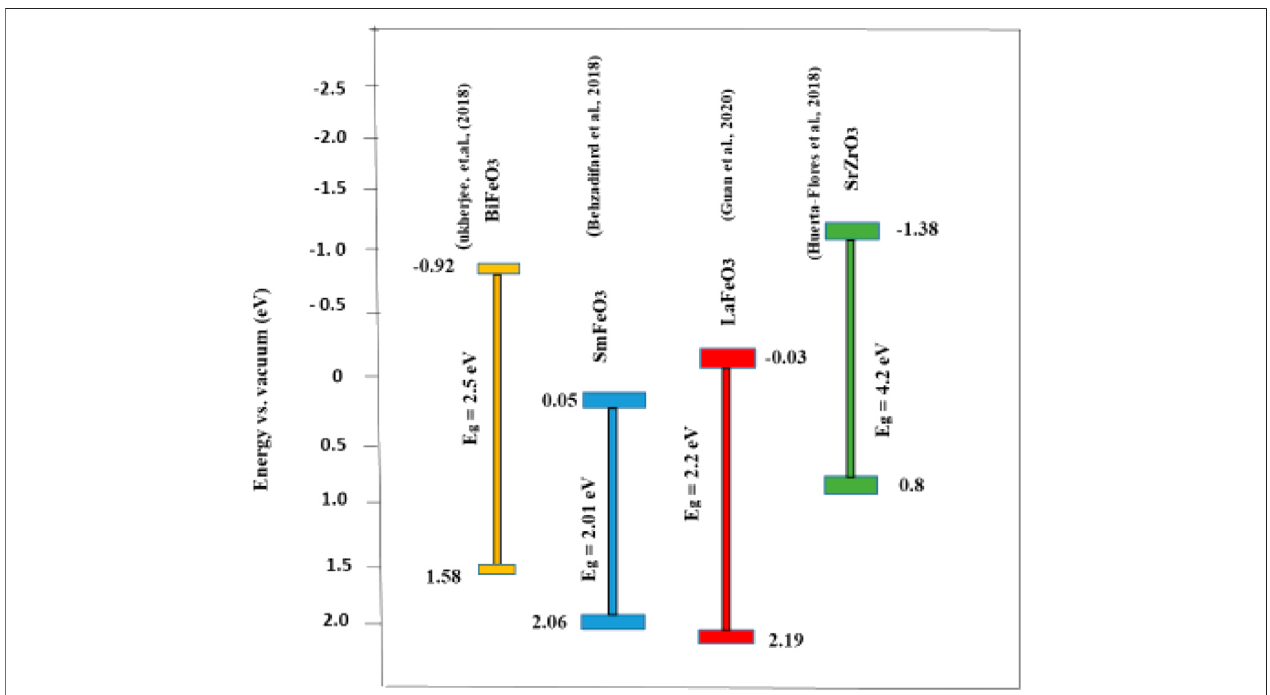
FIGURE 7 | Band positions of some perovskite oxide – based materials in photocatalytic and photoelectrocatalytic treatment of water.